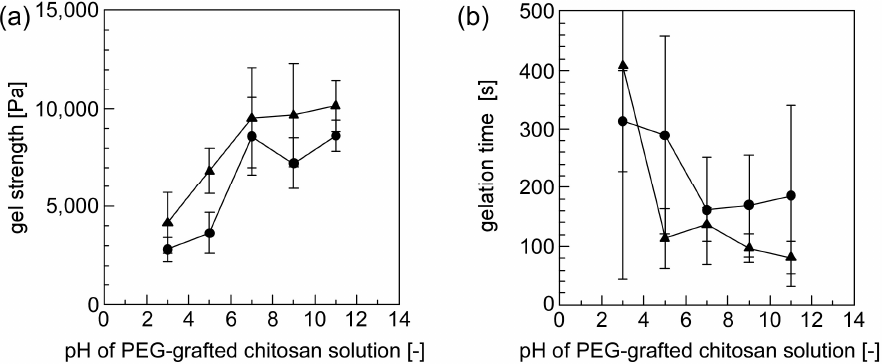
Figure 7. The effect of the pH of solutions containing either PEG-grafted chitosan or a crosslinkable polymeric micelle on their gelation properties (( a ) gel strength and ( b ) gelation time). The pH of the polymeric micelle solution was 5 (closed circle) and 7 (closed triangle).